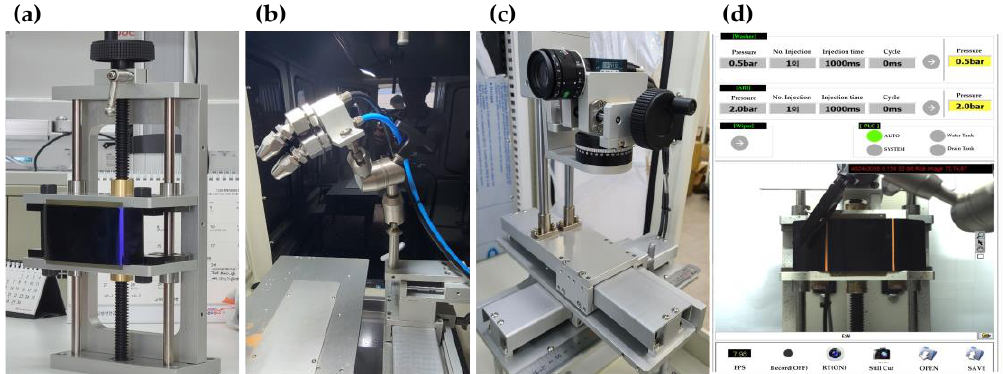
Figure 4. ( a ) Sample fixed part, ( b ) cleaning part, ( c ) data collector part, and ( d ) controller